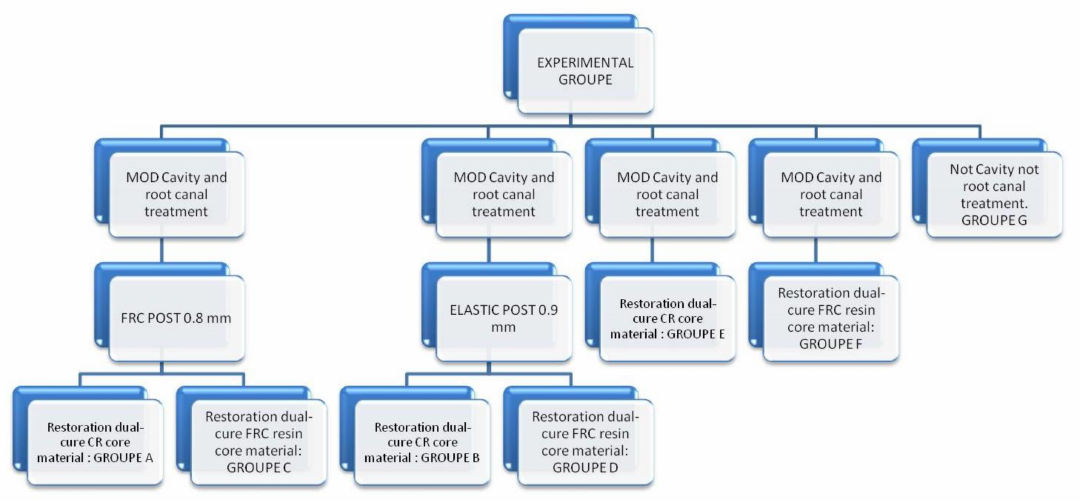
Figure 1. Schematic representation of experimental groups.